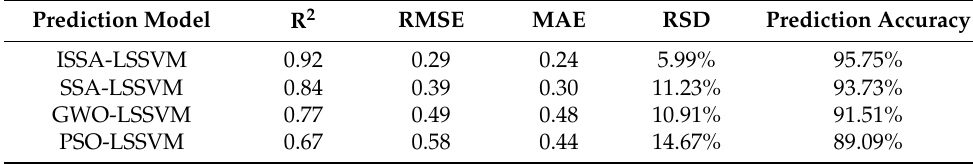
Table 7. ISSA-LSSVM is compared with other prediction